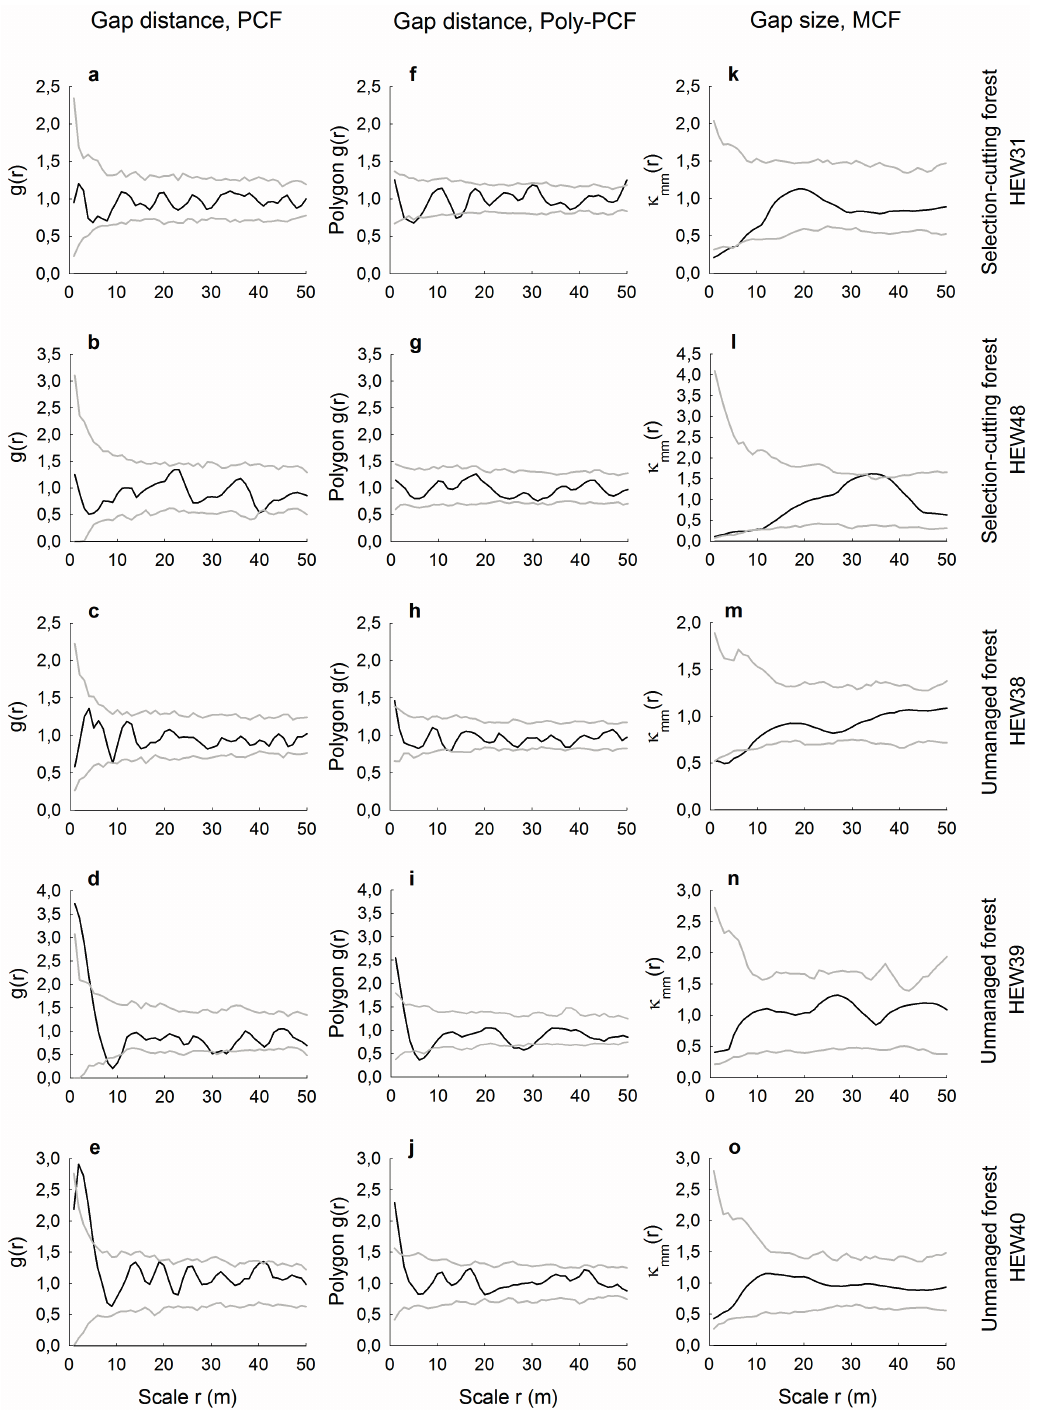
Figure 4. Spatially-explicit gap analyses of selection-cutting (upper two rows) and unmanaged forests (lower three rows; AEW: Schwäbische Alb; HEW: Hainich) with the conventional pair correlation function ( a – e ), the polygon-based PCF ( f – j ) and the mark correlation function ( k – o ). The grey envelopes of the CSR null model ( a – j ) and of the null model of random gap-size distributions ( k – o ) were obtained from the fifth-lowest and fifth- highest values taken from 199 Monte Carlo simulations. If the black line is below or above the null model, gaps were, at neighborhood radius r , regularly spaced or aggregated, respectively ( a – j ), or gap sizes were negatively or positively correlated, respectively ( k – o